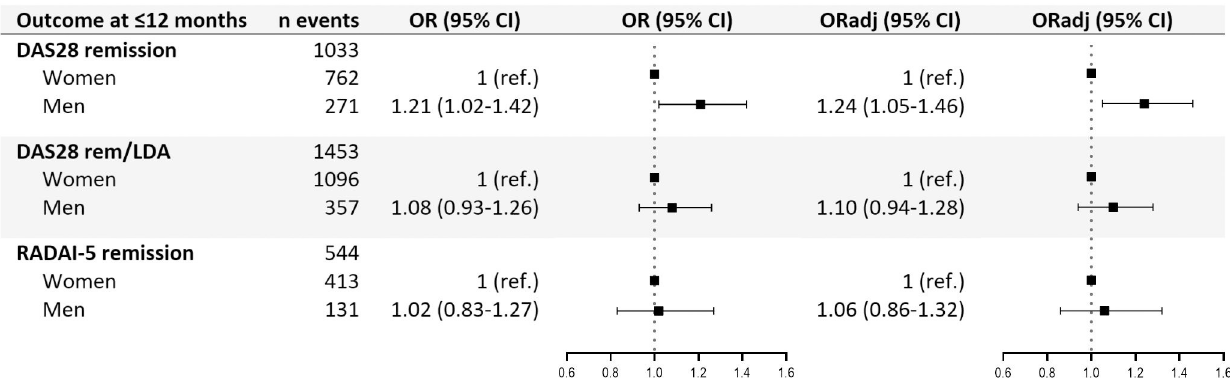
Fig 2. Logistic regression assessing the effect of sex/gender on the study outcomes, with 12-month maximum follow-up. Abbreviations: n number; OR odds ratio; ORadj odds ratio adjusted for age and seropositivity; DAS28 Disease Activity Score 28; rem/LDA remission or low disease activity; RADAI-5 Rheumatoid Arthritis Disease Activity